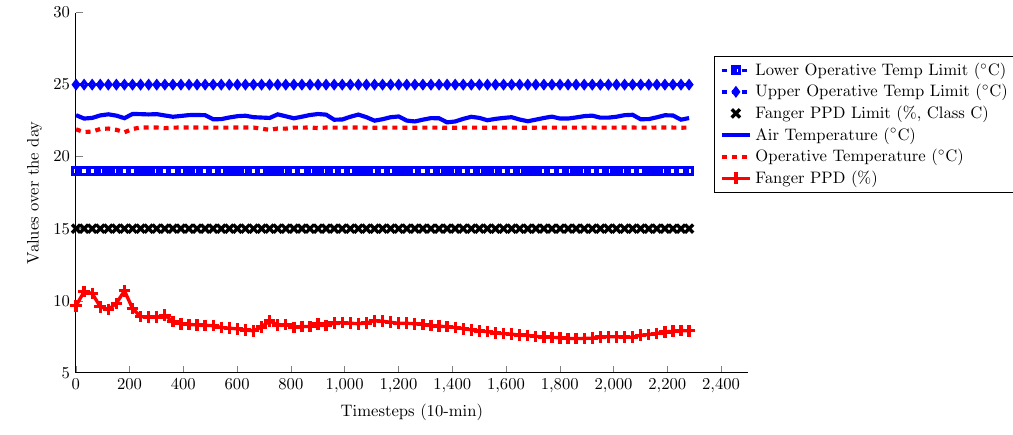
Figure 12. Winter results for Office 08 using the operative temperature thermostat set at 22 ◦ C.